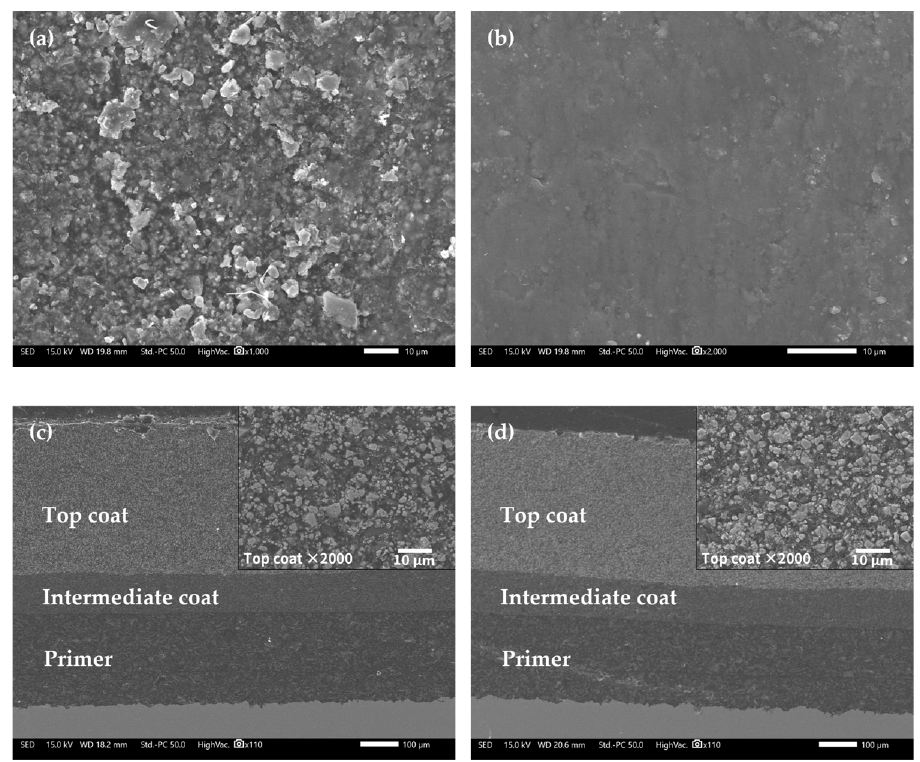
Figure 9. SEM images of FW-1 sample: ( a ) 0 day, surface; ( b ) 160 days, surface; ( c ) 0 day, cross-section; ( d ) 160 days, cross-section.